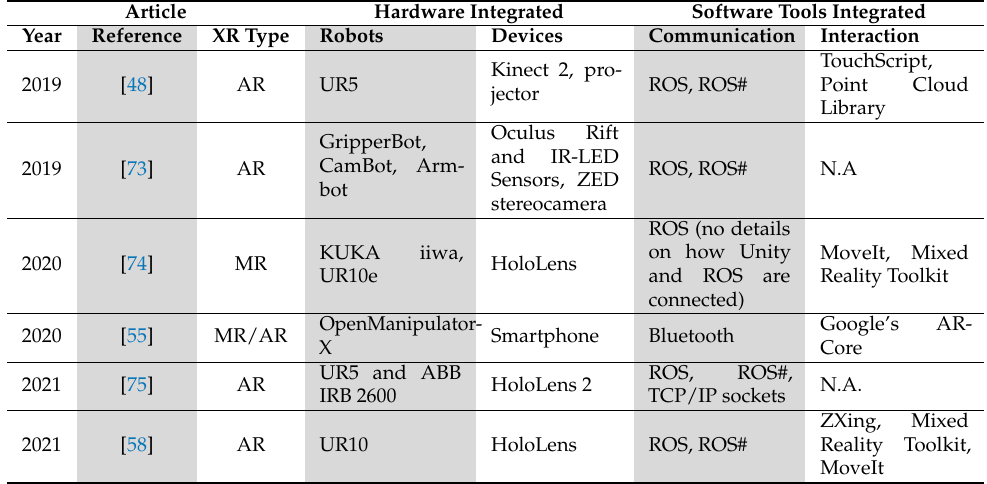
Table 6. Articles presenting XR solutions for programming robots using game